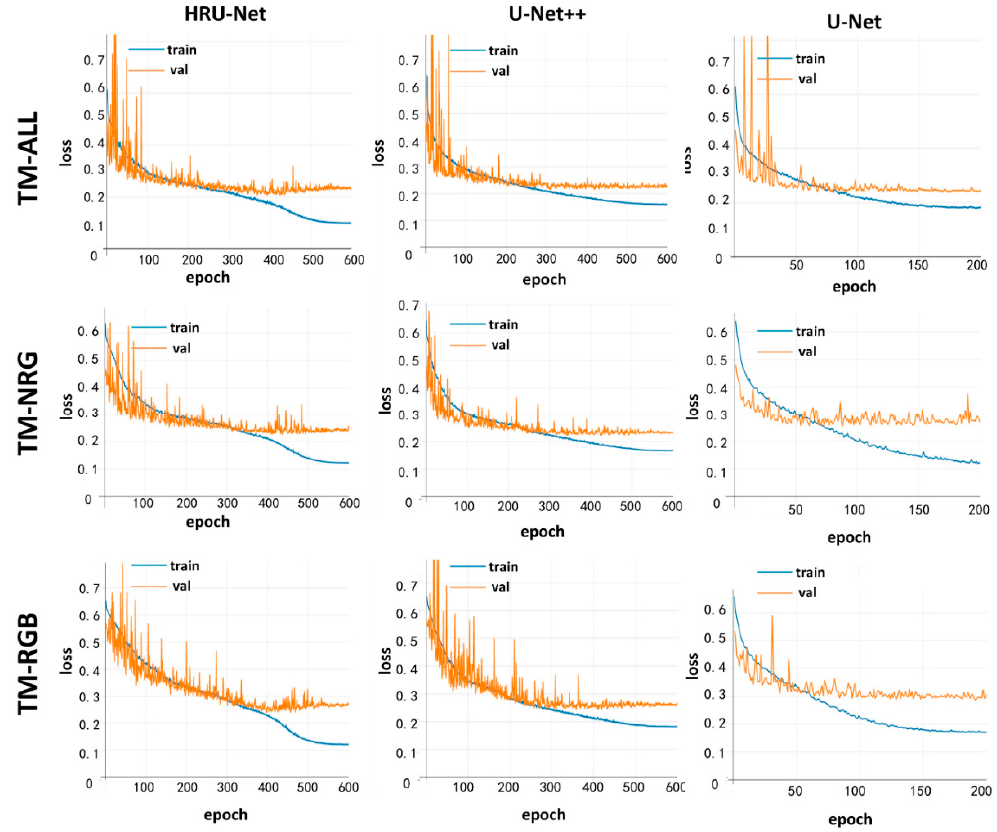
Figure 5. Visualizations of the training history for the HRU-Net, U-Net, and U-Net++ models.